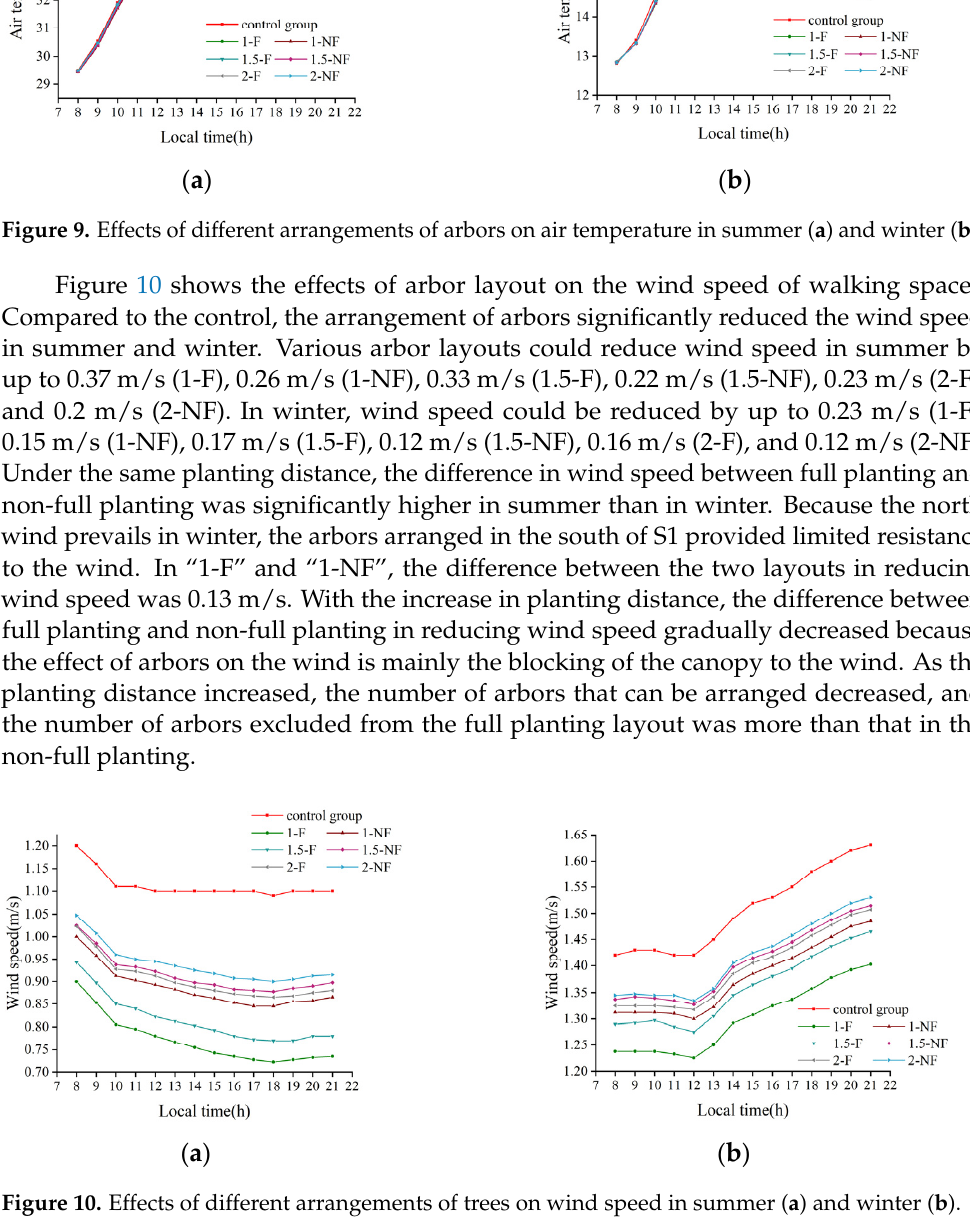
( b ) Figure 11. Effects of different arrangements of trees on outdoor thermal comfort in summer ( a ) and winter ( b ).